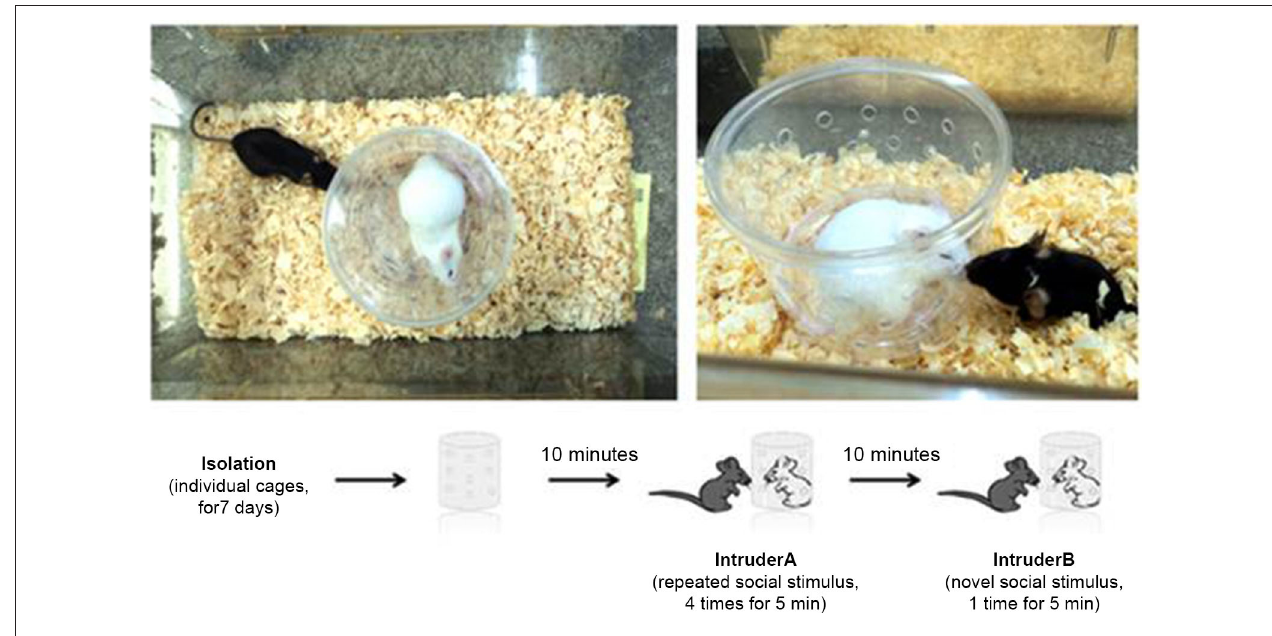
(second intruder) was placed in the same acrylic chamber (which was properly cleaned to remove the odors of the previous intruder), and the sniffing time was quantified